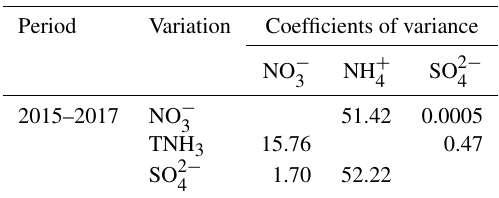
Table 3. Sensitivity analysis of NSA (nitrate, sulfate and ammo- nium) concentration variations during the different observation pe- riods. Period Variation Coefficients of